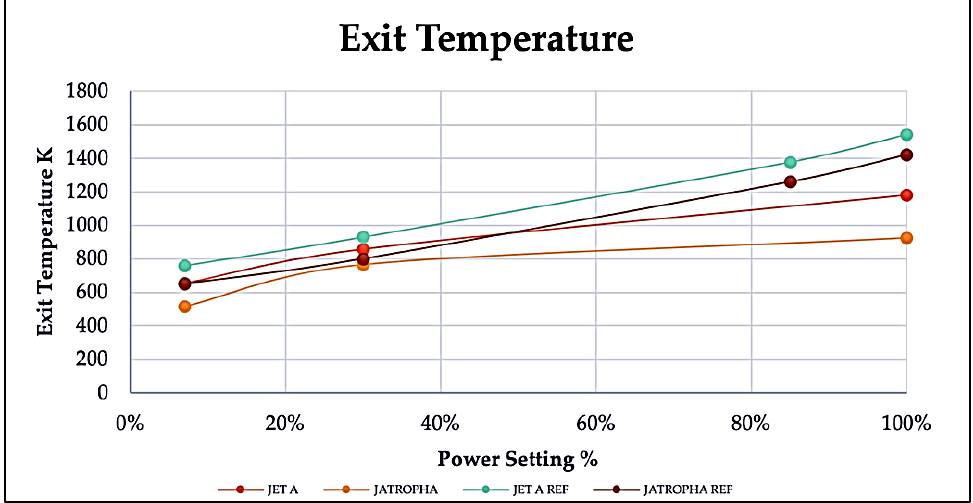
Figure 5. Exit temperature of the combustion chamber using Jet-A fuel and Jatropha biofuel. Solid lines show the current research and dash lines show the work done by Olivera and Brojo [38].